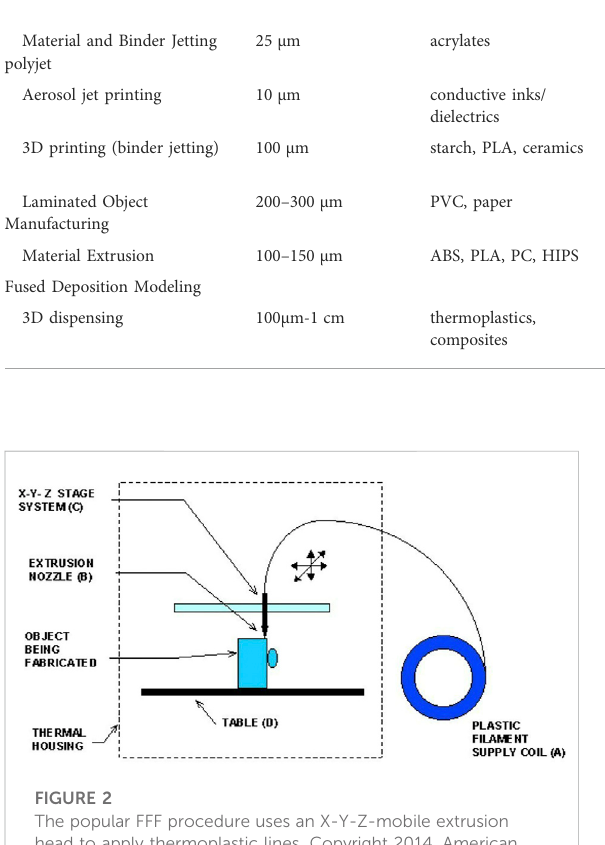
FIGURE 2 The popular FFF procedure uses an X-Y-Z-mobile extrusion head to apply thermoplastic lines. Copyright 2014, American Chemical